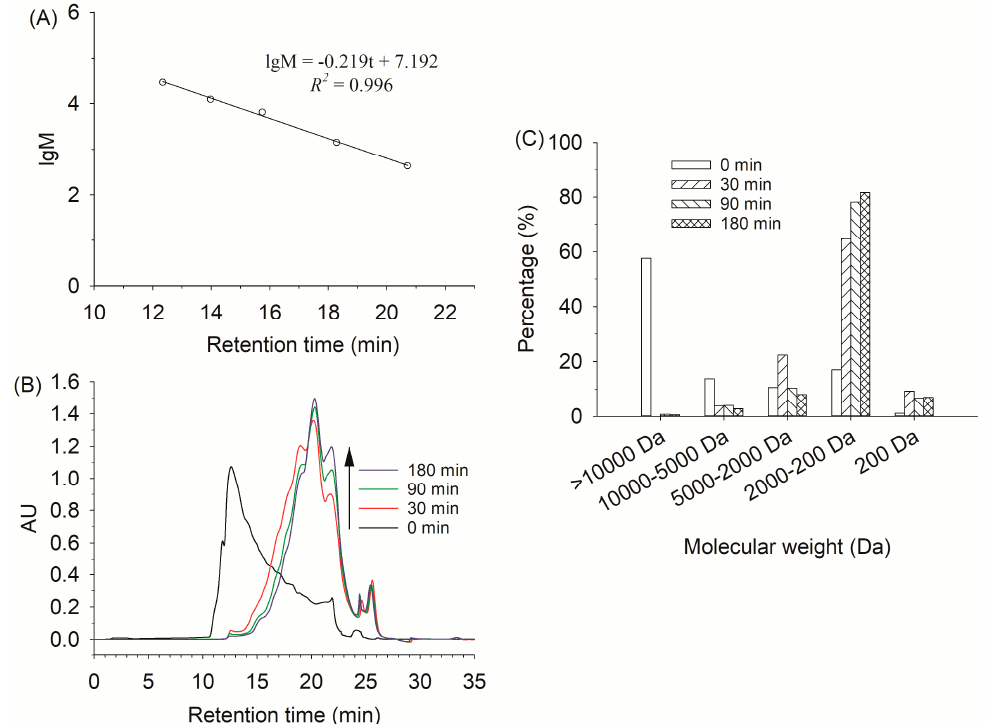
Figure 4. A standard curve ( A ) of molecular weight standards and their retention time using TSK-Gel G2000 SWxl column for analysis. Standards: carbonic anhydrase (29,000 Da), cytochrome C (12,500 Da), aprotinin (6,511.4 Da), bacitracin (1,422.69 Da) and hippuryl-histidyl-leucine (429 Da). Gel filtration chromatogram ( B ) and molecular weight distribution ( C ) of gelatin hydrolysates for different hydrolysis times (0–180 min).